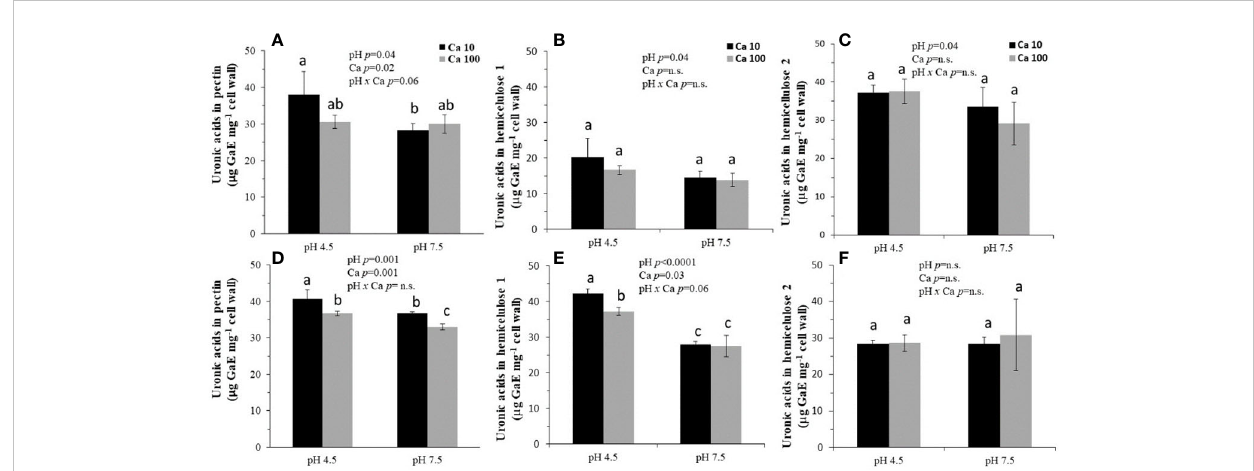
FIGURE 3 Uronic acids content of the cell-wall fractions pectin (A, D) , hemicellulose 1 (B, E) and hemicellulose 2 (C, F) extracted from blueberry roots on Day 1 (A – C) and Day 3 (D – F) . Southern highbush blueberry ( Vaccinium corymbosum , cv. Windsor) plants were cultured for 1 day and 3 days in nutrient solutions of pH 4.5 or 7.5 containing 10 or 100 mg L -1 Ca. Means in the sub- fi gures followed by different letters (a, b, c) are different according to LSMeans Student's t test One cm of root tip was excised and cell-wall polysaccharides were fractionated into pectin and hemicellulose fractions and the uronic acid content of each fraction was determined. Data are means ± SD ( n = 3). All data were subjected to a three-way analysis of variance (ANOVA).